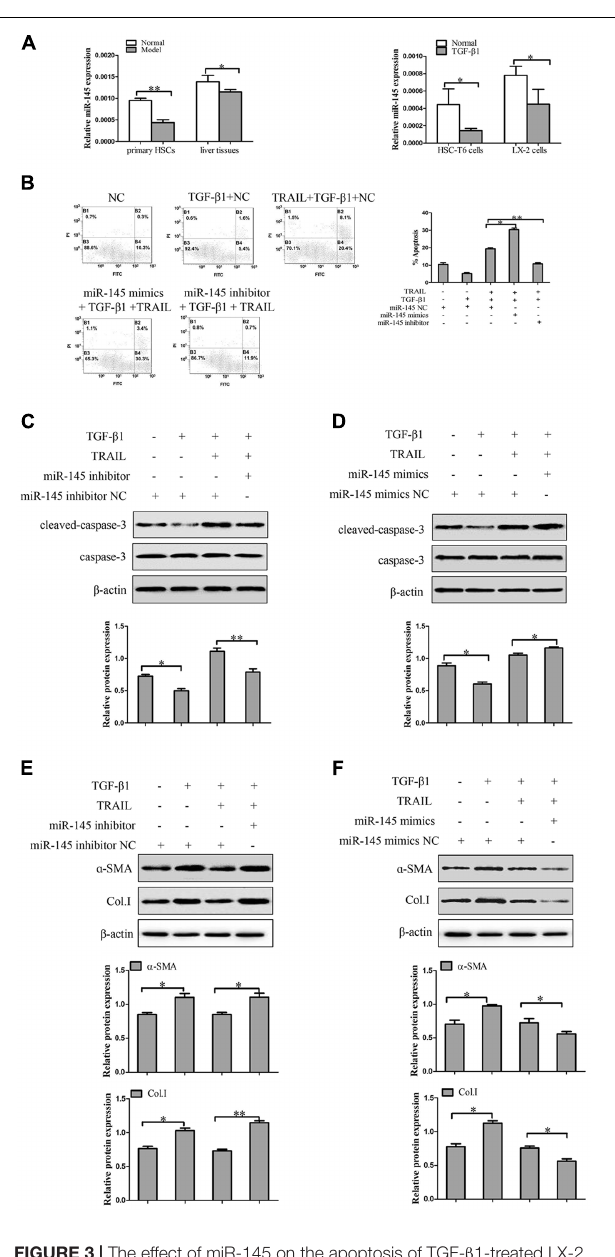
FIGURE 3 | The effect of miR-145 on the apoptosis of TGF- β 1-treated LX-2 cells induced by TRAIL. (A) The expression of miR-145 was detected by quantitative real-time PCR in liver fibrosis tissues, primary HSCs and activated HSCs. (B) miR-145 inhibitor and miR-145 mimics, respectively decreased and increased the rate of apoptosis in activated LX-2 cells that were pretreated with TRAIL (10 ng/ml) for 24 h. (C) The protein expression of cleaved of caspase-3 was measured by Western blot in activated LX-2 cells transfected with miR-145 mimics that were pretreated with TRAIL (10 ng/ml) for 24 h. (D) The protein expression of cleaved of caspase-3 was assessed by Western blot in activated LX-2 cells transfected with miR-145 inhibitor that were pretreated with TRAIL (10 ng/ml) for 24 h. (E,F) The expression of α -SMA and Col. I protein was determined by Western blot in activated LX-2 cells that were pretreated with TRAIL (10 ng/ml) for 24 h. The assays were performed at least three times with similar results. Data are shown as the mean ± SD ( n = 3) of one representative experiment. ∗ p < 0.05, ∗∗ p < 0.01 versus normal